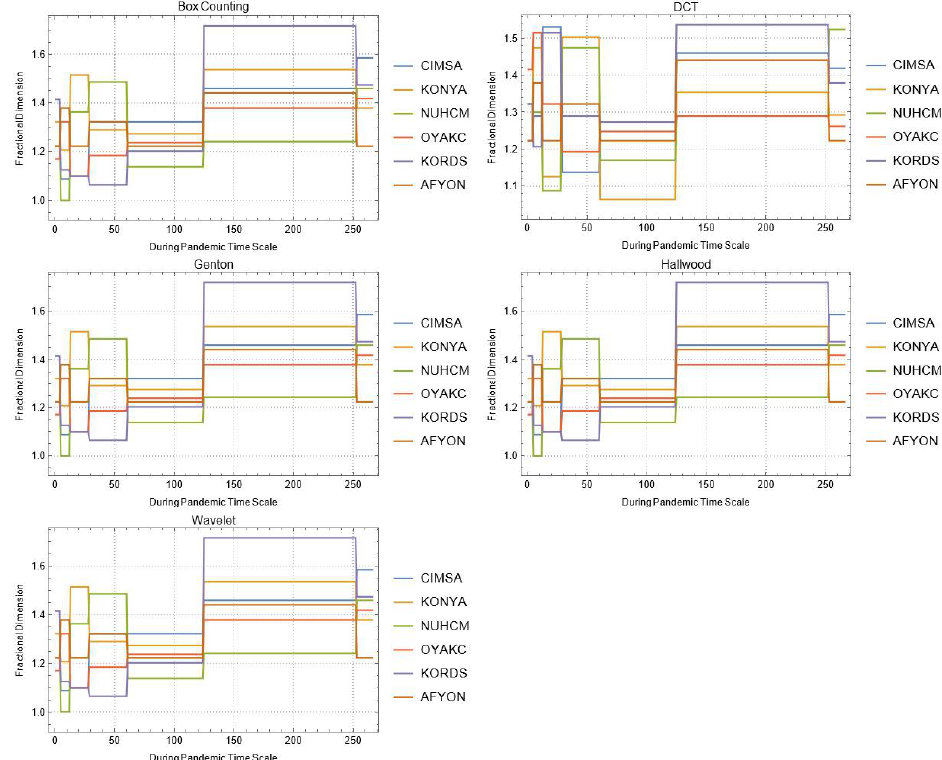
Figure A7. Daily changes of fractal dimensions during the pandemic (machineries).